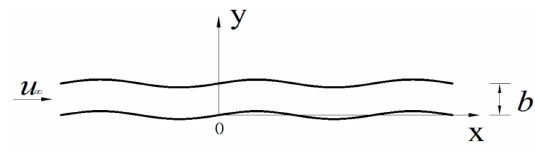
Figure 2. Platform of a sinusoidal river and its coordinate